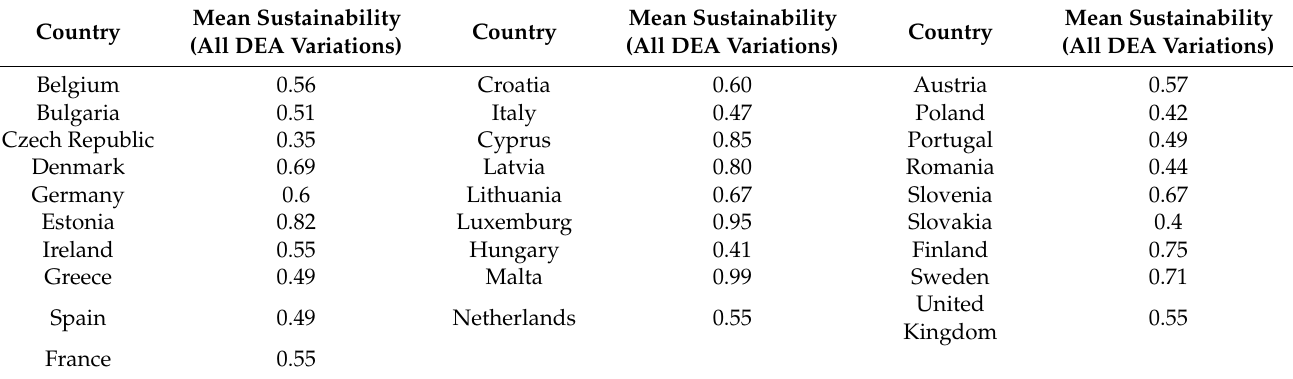
Table 5. Mean sustainability calculated with all DEA